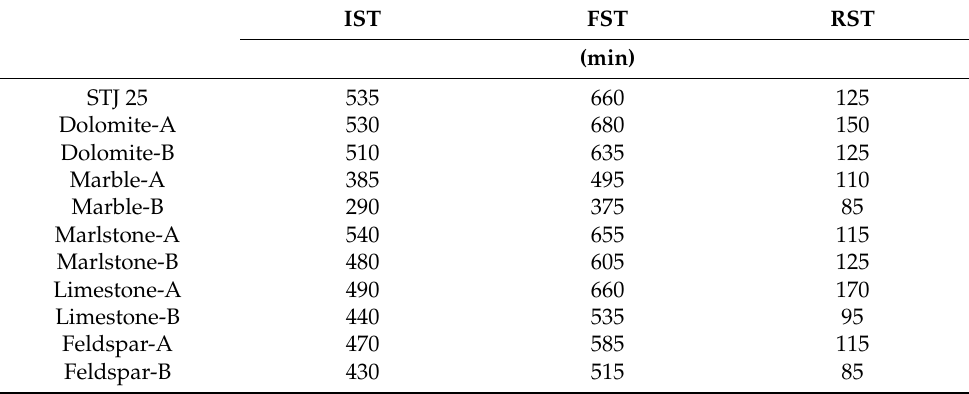
Table 3. The setting parameters of geopolymer composites with different types of waste stone